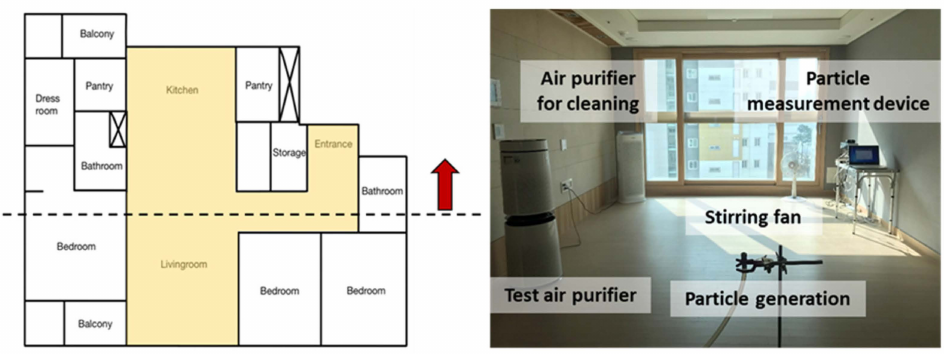
Figure 3. A photo of the set experimental devices at the test